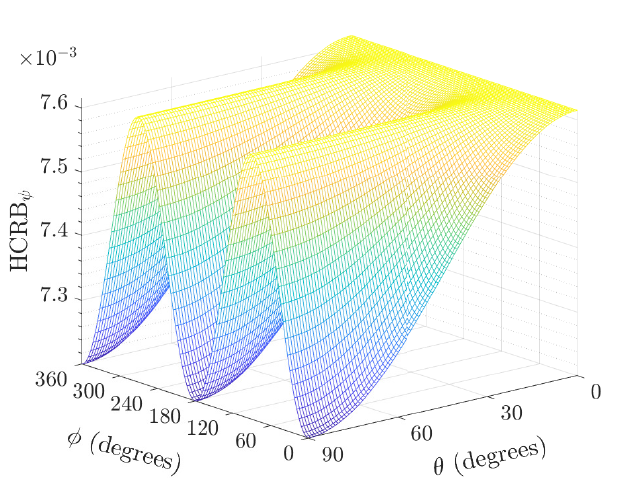
Figure 8. Plot of HCRB ψ versus the direction-of-arrival polar and azimuth angles for K = 100 samples, σ 2 s / σ 2 n = 5, and σ v = 0.0873